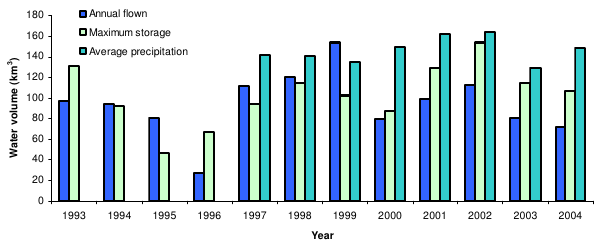
Figure 6. Time series of annual maximum of surface water storage volume (light green), 1 Fig. 6. Time series of annual maximum of surface water storage annual water volume flown in the Lower Ob’ basin (blue), and annual water volume of 2 volume (light green), annual water volume flown in the Lower Ob’ precipitation. 3 Basin (blue), and annual water volume of precipitation.